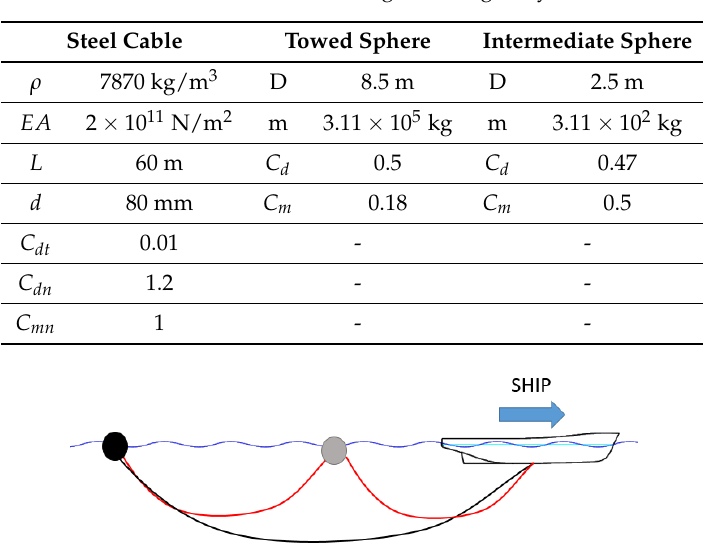
Table 3. Data on towing a floating body.